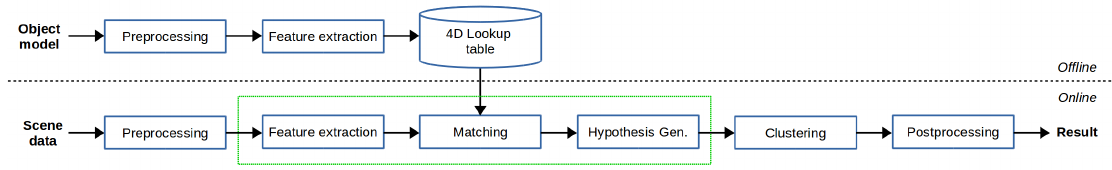
Figure 5. Proposed method pipeline. The green fine dotted box represents the iterative implementation of the steps Feature Extraction , Matching and Hypothesis generation for each scene